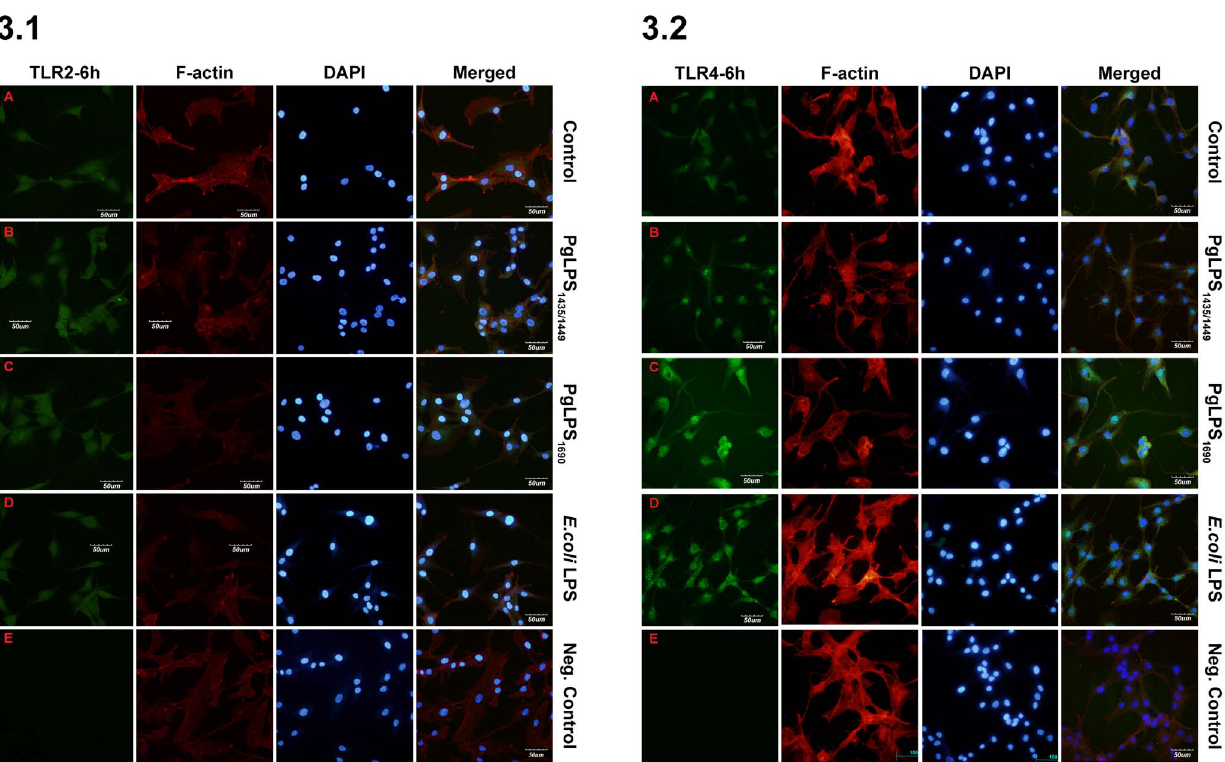
Figure 3. Confocal images showing positive TLR2 (3.1) and TLR4 (3.2) expression, in HGFs , following LPS stimulation. The cells were left untreated (A) or stimulated with P. gingivalis (Pg) LPS 1435/1449 (PgLPS 1435/1449 ) (B) PgLPS 1690 (C) and E. coli LPS (D) at 1 m g/ml for 6 h. Cells were permeabilized with 0.1% Triton X-100 and subsequently stained with primary antibodies against TLR2, TLR4 and the correspondent secondary antibody labeled Alexa fluor 488 anti-rabbit, and subsequently stained with alexa fluor 555 phalloidin for F-actin. Merged images present the combined TLR2/TLR4, F-actin and nuclear staining (DAPI). Negative control: E. One representative experiment from three independent experiments is shown. Bar=50 m